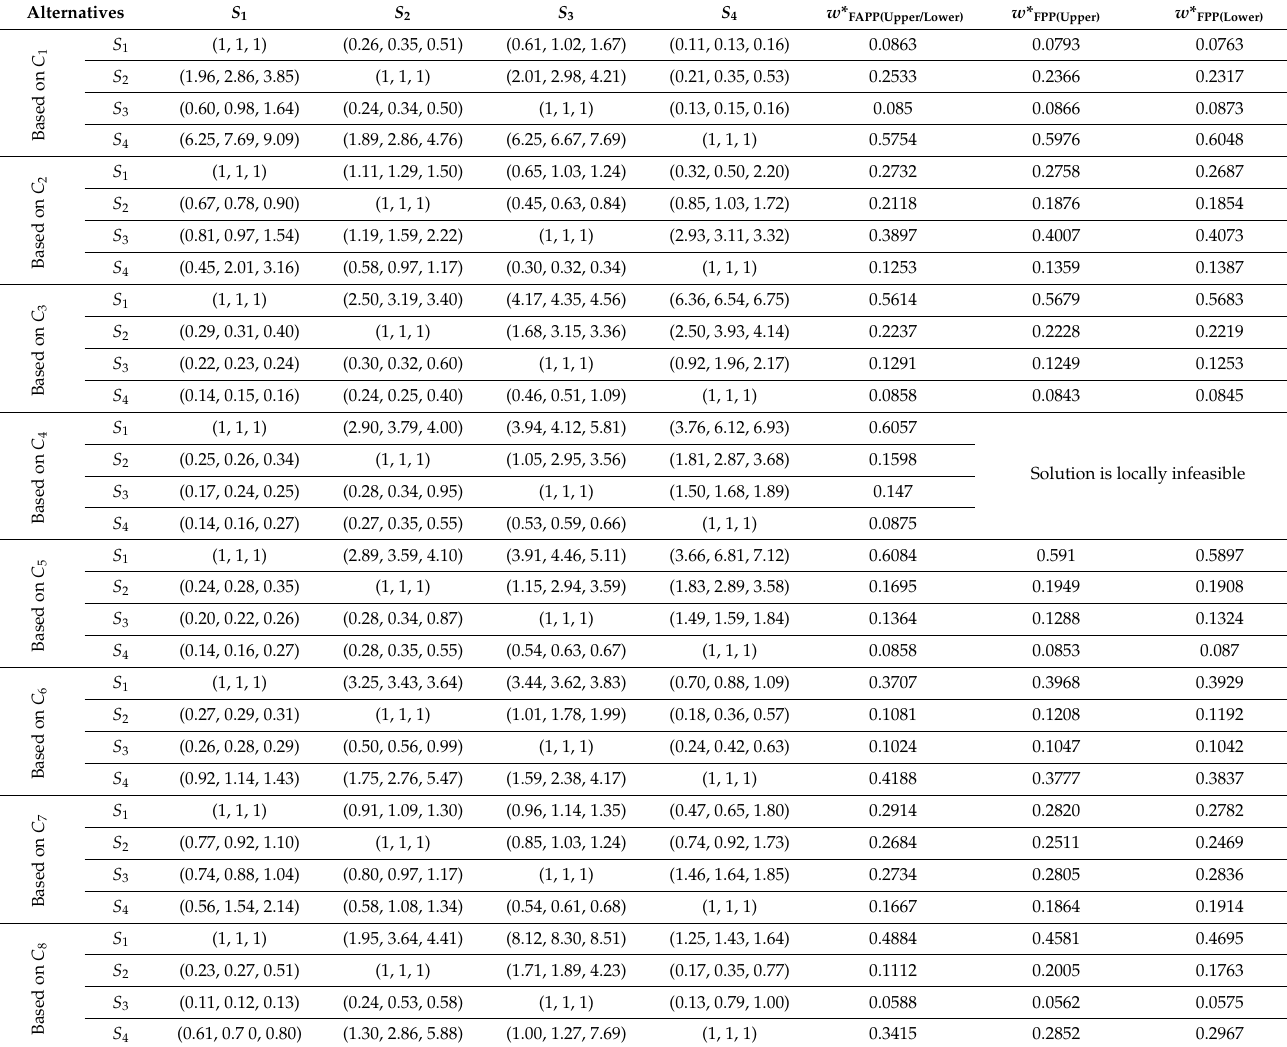
Table 2. The fuzzy pairwise comparison matrix of SMSs and weights results.